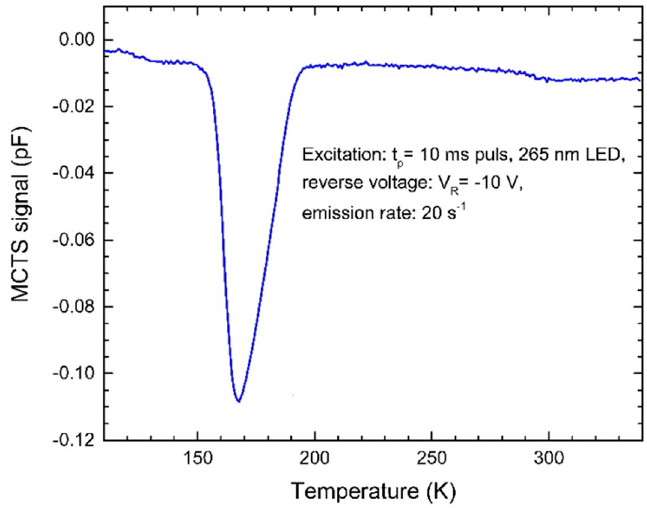
Figure 3. The minority carrier transient spectroscopy (MCTS) spectrum for the as-grown n -type 4H– SiC semi-transparent SBD (emission rate 20 s − 1 ). The optical excitation was carried out with 10 ms pulses of 265 nm LED light. The SBD was kept at the constant reverse bias V R = − 10 V.